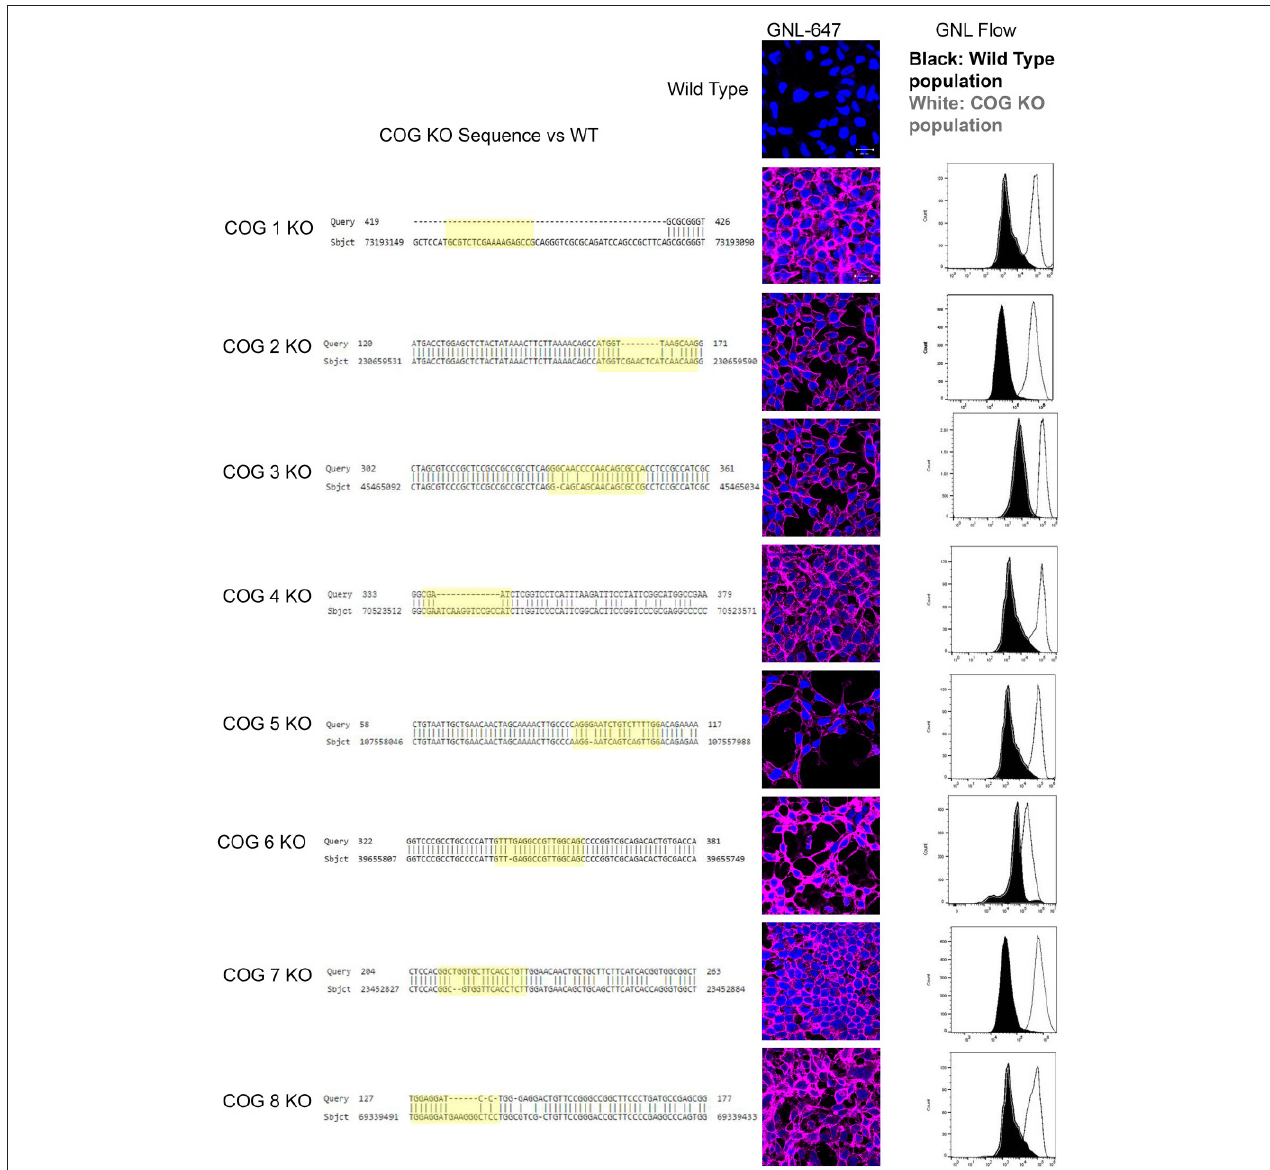
FIGURE 1 | COG KO validation. Left column : Sequence alignment of mutant and control DNA. Chromosomal DNA was amplified at the CRISPR target region by high fidelity PCR. The expected cut site based on the guide RNA is highlighted in yellow. The central column shows plasma membrane staining of WT HEK293T and COG KO cells with Galanthus nivalis lectin (GNL-pink). Nuclei stained with DAPI (blue). Right column : cells were analyzed using flow cytometry for GNL staining (wild-type cells are in black, COG KO cells are in white).